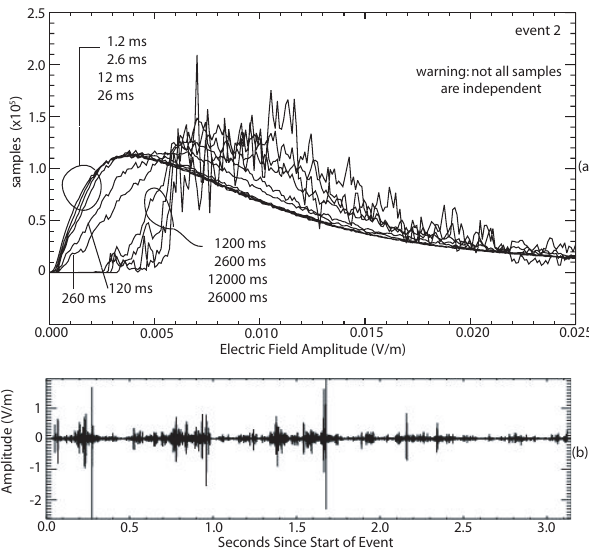
Fig. 2. (a) Electric fields of the the Langmuir burst denoted as event 1 in Figure 1b, in histogram form: the horizontal axis represents values of the electric field amplitude into which data have been binned, and the vertical axis gives the number of occurrences in each bin. Ten curves are shown, corresponding to widths of running averages of electric field amplitudes ranging from 1.2 microseconds to 26 ms (from top to bottom). (b) Time series of the sampled electric field amplitudes in event 2, corrected for the automatic gain control and decimated by a factor of 100.